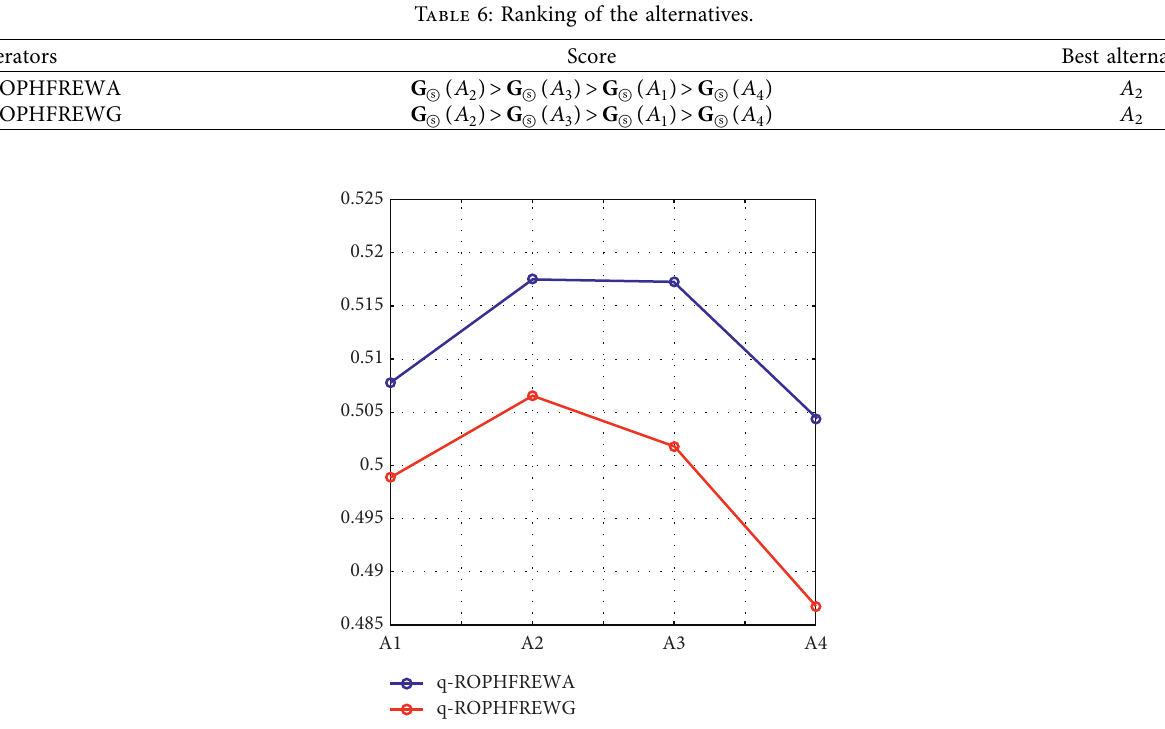
Figure 4: Alternatives using EWA and EWG